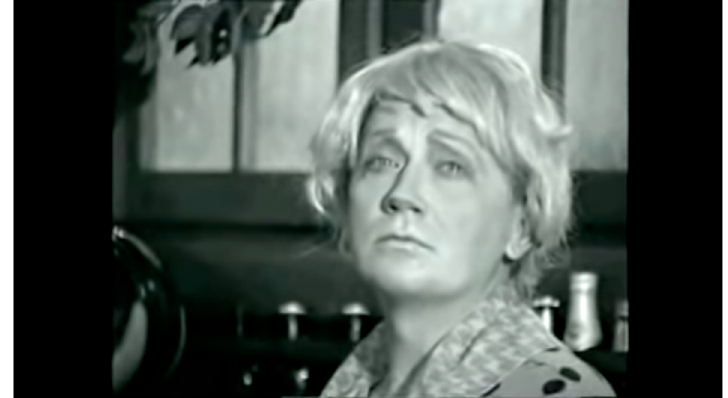
Figure 17. Vlad Mamyshev-Monroe as Stirlitz’swife in Café Elefant